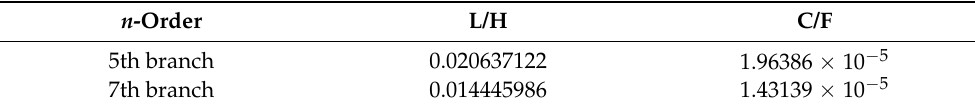
Table 2. Filtering branch parameters.